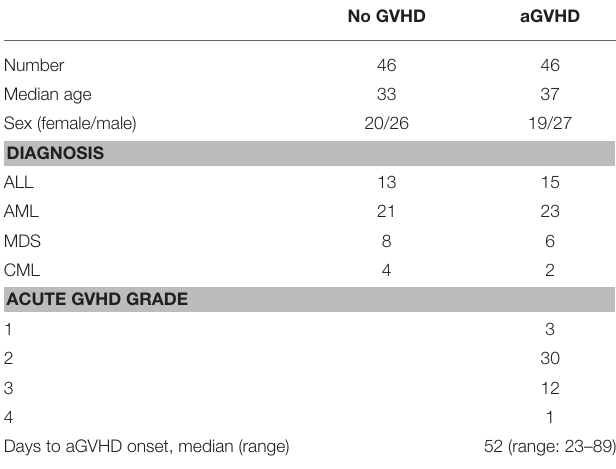
TABLE 1 | Clinical characteristics of